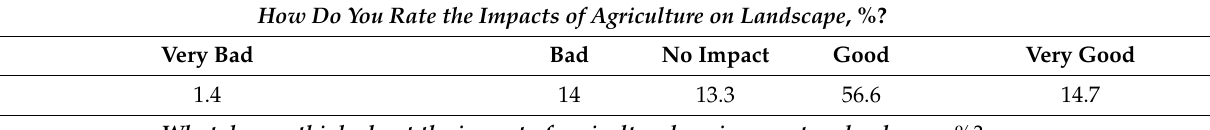
Table 3. Attitudes and beliefs regarding the impacts of farming on the landscape.